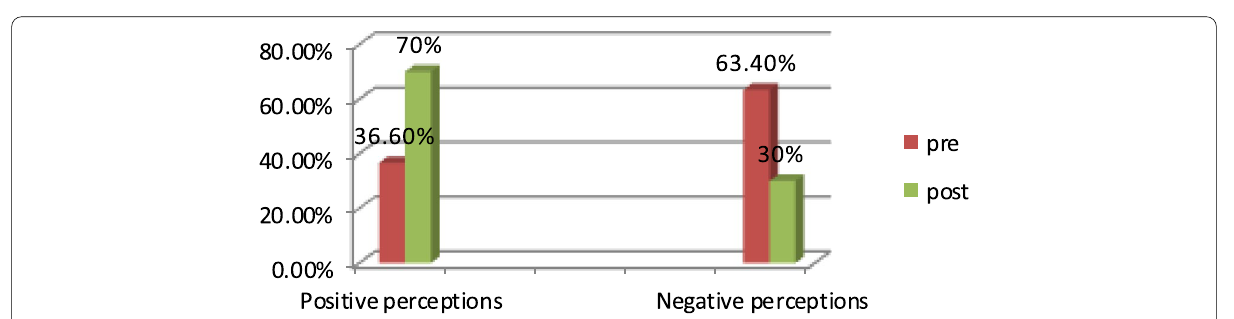
Fig. 4 Total bullying perceptions pre and post a psychoeducational intervention ( n